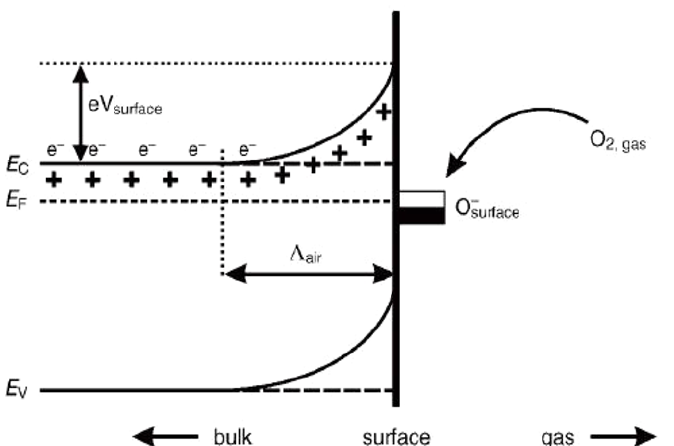
Figure 1. Simplified model illustrating band bending in a wide band gap semiconductor after chemisorption of charged species (here the ionosorption of oxygen) on surface sites. EC, EV and EF denote the energy of the conduction band, valence band and Fermi level, respectively, while Λ air denotes the thickness of the space charge layer, and eV surface denotes the potential barrier. The conducting electrons are represented by e − , and + represents the donor sites. (Reprinted with permission from [64], Copyright 2003,